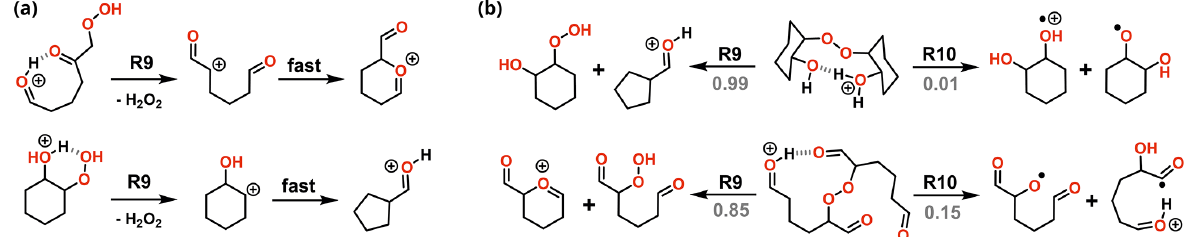
Figure 9. Major reaction channels for decomposition of ROOH (a) and ROOR (b) obtained from OH oxidation and ozonolysis of cyclohex- ene. Branching ratios are shown in gray when relevant.